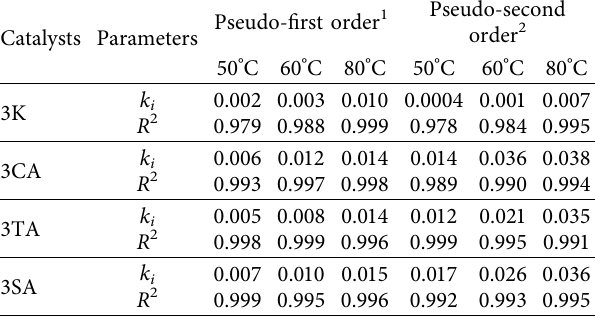
Table 3: Results of the kinetic modeling of transesterification of safflower oil with methanol using the best alkaline and acidic heterogeneous